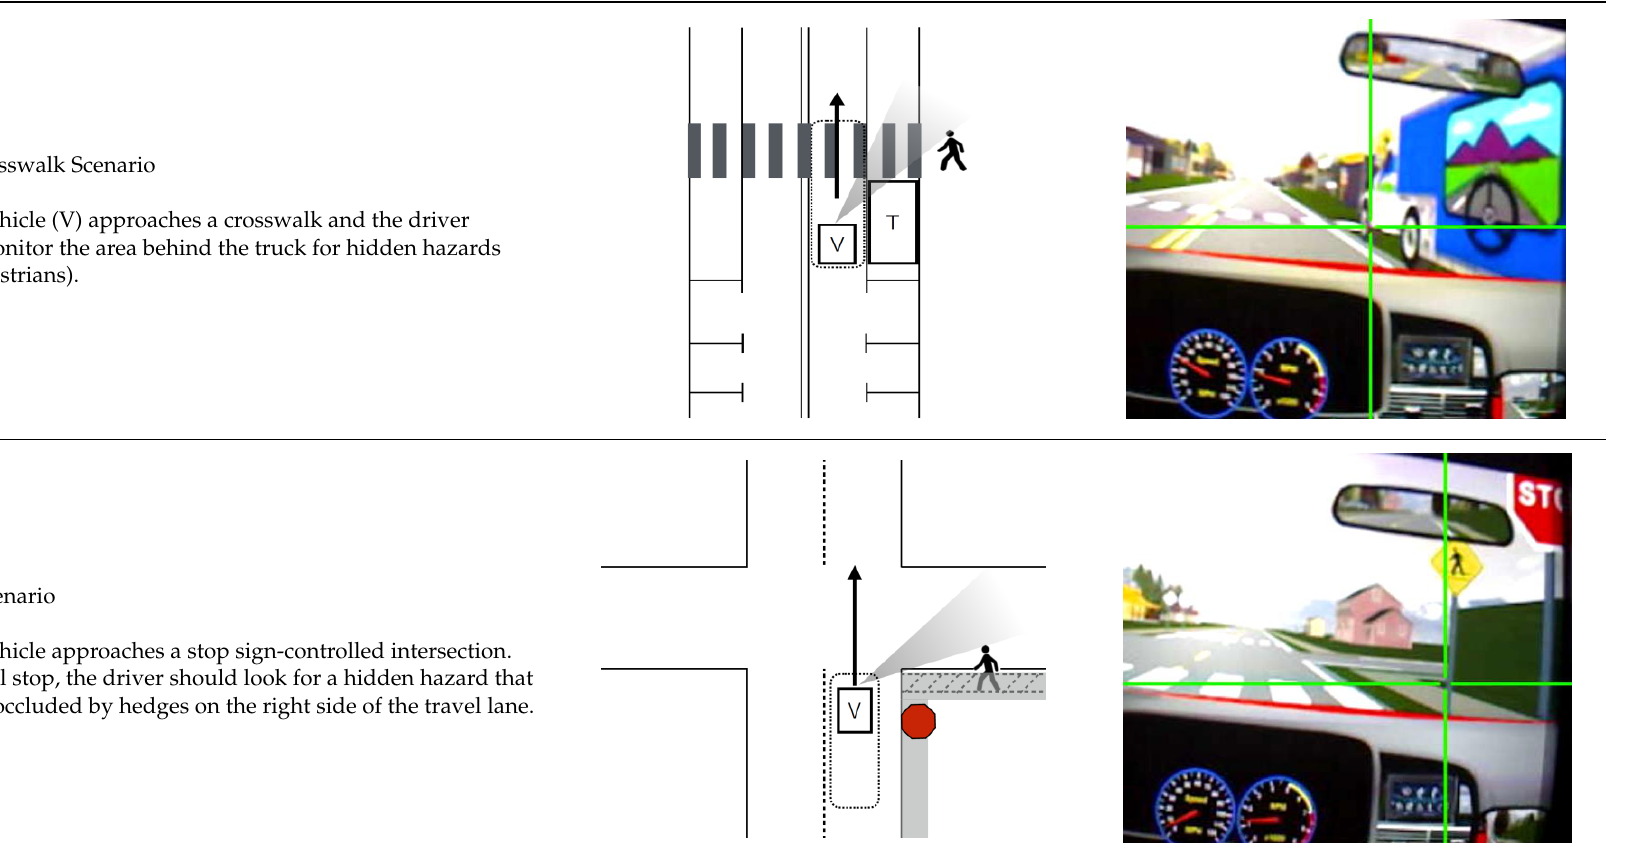
Table 1. In schematic representation of each scenario, the dotted square depicts the launch zone and the graded cone depicts the target zone. A perspective view with a crosshair indicating the location of a correct glance toward the target zone.